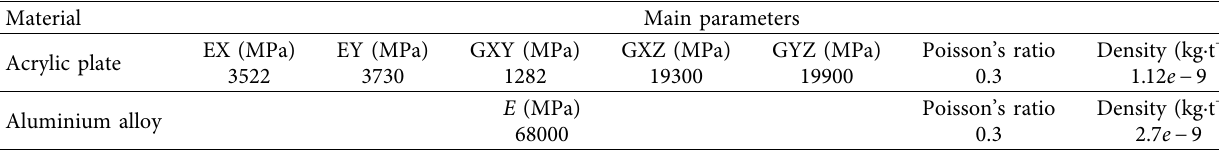
Table 6: Main material parameters of the ground verification test